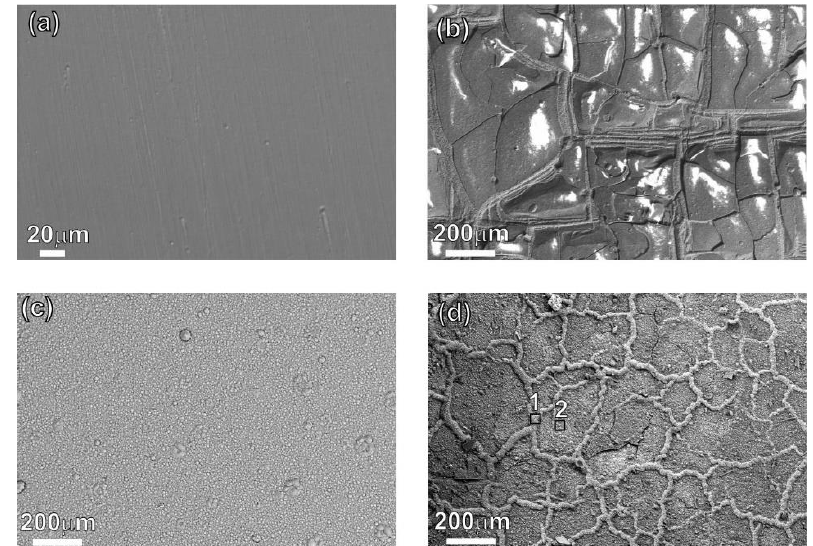
Figure 4. SEM images of coatings on the basis of Si-Al-N: coatings deposited on the initial surface of the titanium alloy: in initial state ( a ), after 500 cycles ( b ). Coating applied to titanium alloy treated with copper ions in initial state ( c ) and after 1500 cycles ( d ).